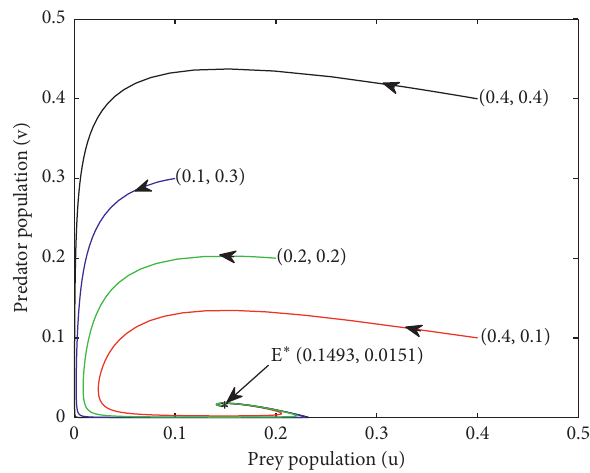
Figure 14: Interior singular point E ∗ ( 0 . 1493 , 0 . 0151 ) for predator- prey system (4) is globally asymptotically stable with the param- � 0 . 045, δ � 0 . 01, c � 0 . 15, α � 0 . 9, β � 0 . 5, eters specified as r 0 1 � 0 . 05. The initial values are shown within the θ � 0 . 4, and δ 2